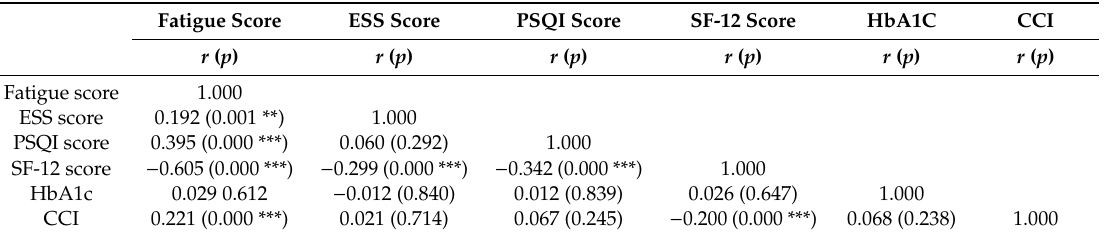
Table 2. Correlation between fatigue, ESS, PSQI, SF-12, HbA1C, and comorbidities ( n = 307).